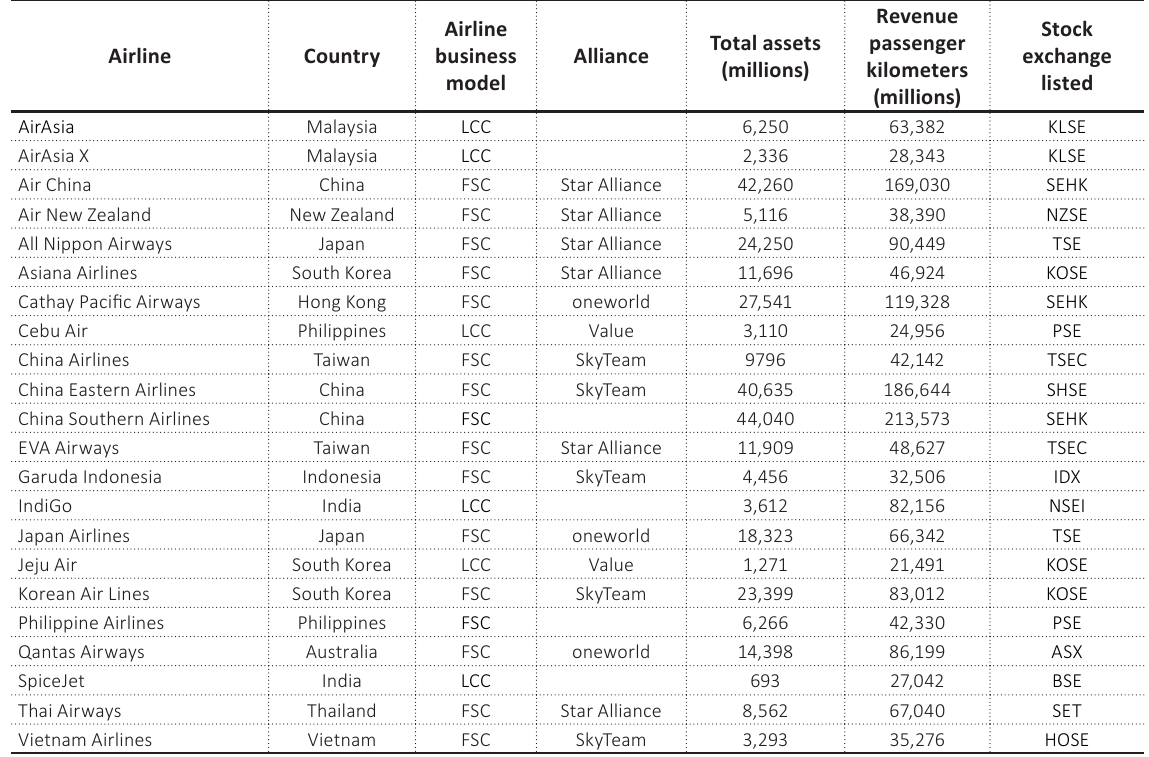
Table 2. Descriptive statistics of airlines in the Asia-Pacific region